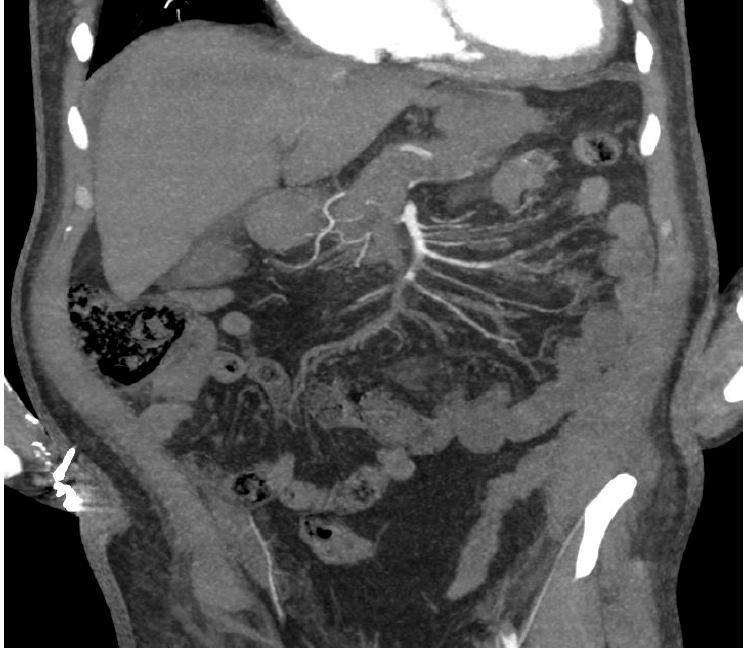
Figure 5. CT angiography, coronal planes, arterial phase, MIP reconstruction. Extended thrombosis in the superior mesenteric artery and its branches can be noted, with hypoperfusion of the